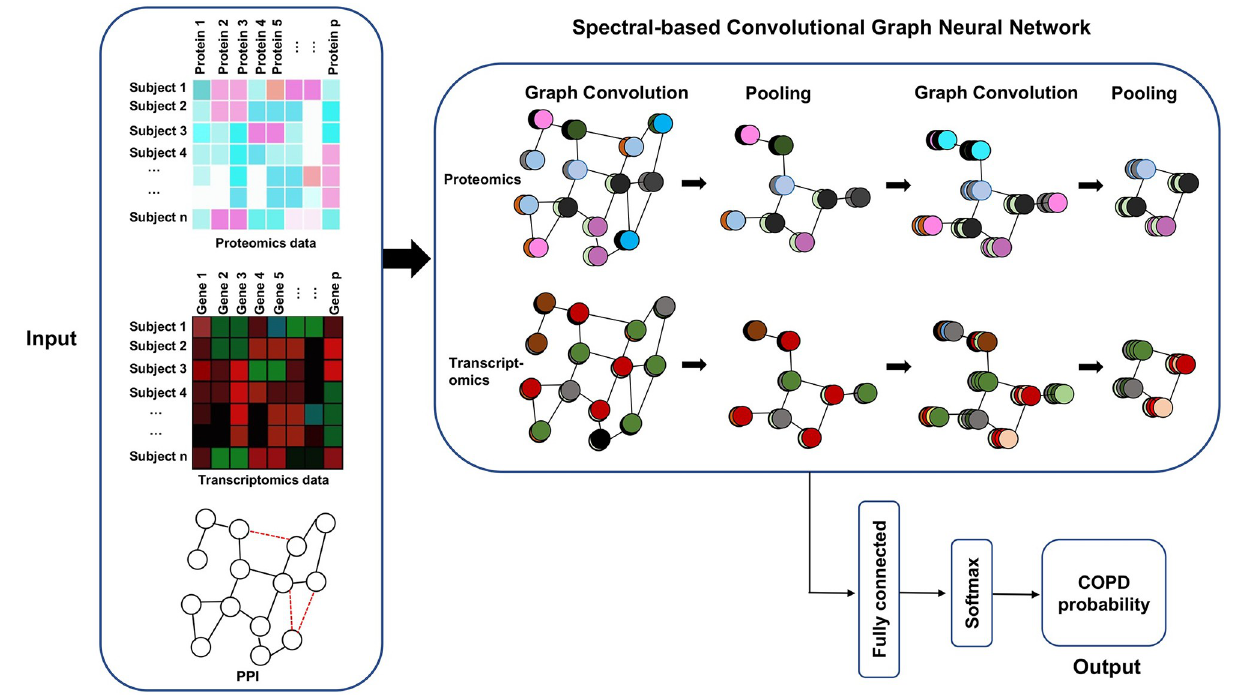
Fig 1. Overview of spectral-based Convolutional Graph Neural Network (ConvGNN) for COPD classification with single or multi-omics data. The inputs are a protein-protein interaction network (PPI) and omics data which could be single omics data only or multi-omics data. The PPI network could be retrieved from STRING databases or reconstructed from the AhGlasso algorithm. The red edges between nodes represent changes between the original PPI from STRING and the updated PPI with AhGlasso. The input is fed into a Spectral-based Convolutional Graph Neural Network, which typically includes layers for graph convolution and pooling to extract features with different kernels. The graph convolution and pooling could be repeated as shown on the top right. The resultant features will be passed to fully connected layers to calculate the probability of COPD using the softmax